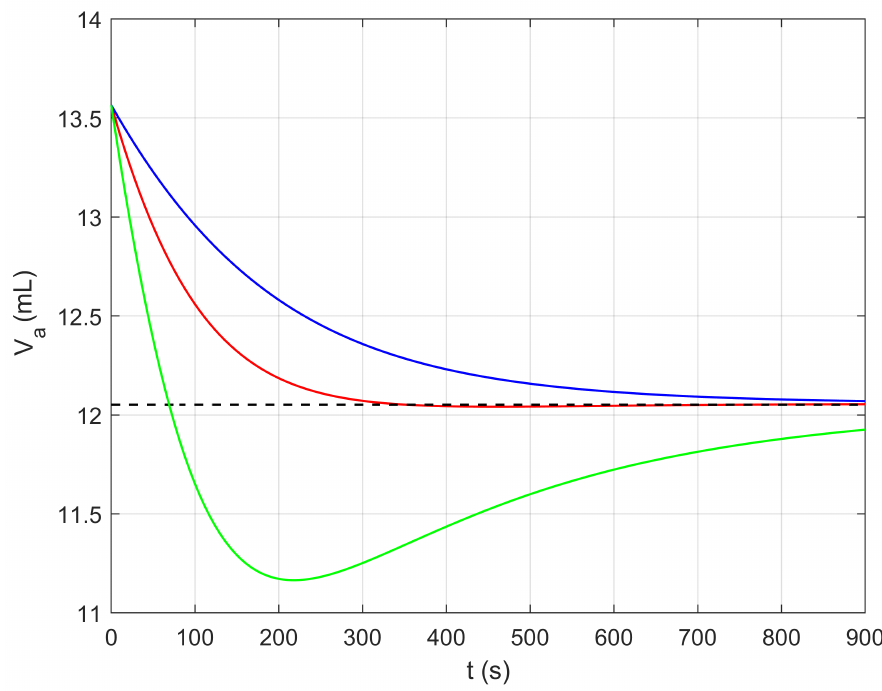
Figure 3. Arterial–arteriolar blood volume V a time behavior (solid red line for κ 1 = 0.002, κ 2 = 0.01, M 1 = 0.1738, M 2 = 3.46 × 10 − 4 ; solid blue line for κ 1 = 0.002, κ 2 = 0.005, M 1 = 0.1738, M 2 = 3.46 × 10 − 4 ; solid green line for κ 1 = 0.003, κ 2 = 0.01, M 1 = 0.1738, M 2 = 5.19 × 10 − 4 ) and its reference value V ar (dashed line).